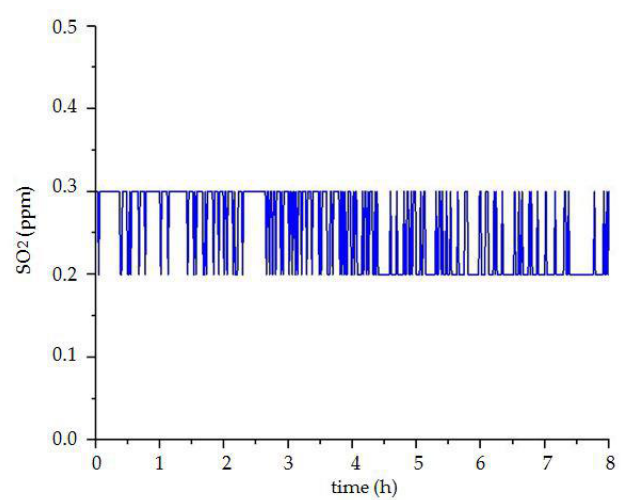
Figure 25. The curve of sulfur dioxide concentration.